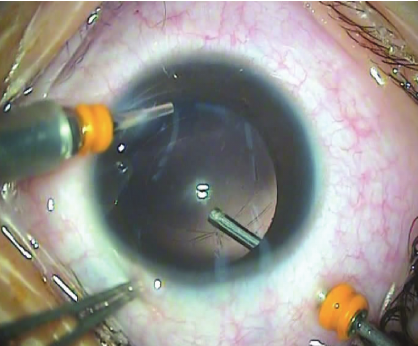
Figure 4: Intraoperative video frame shows the operated eye of the pars plana group B after anterior capsulotomy, after lensectomy, after posterior capsulotomy, and during anterior